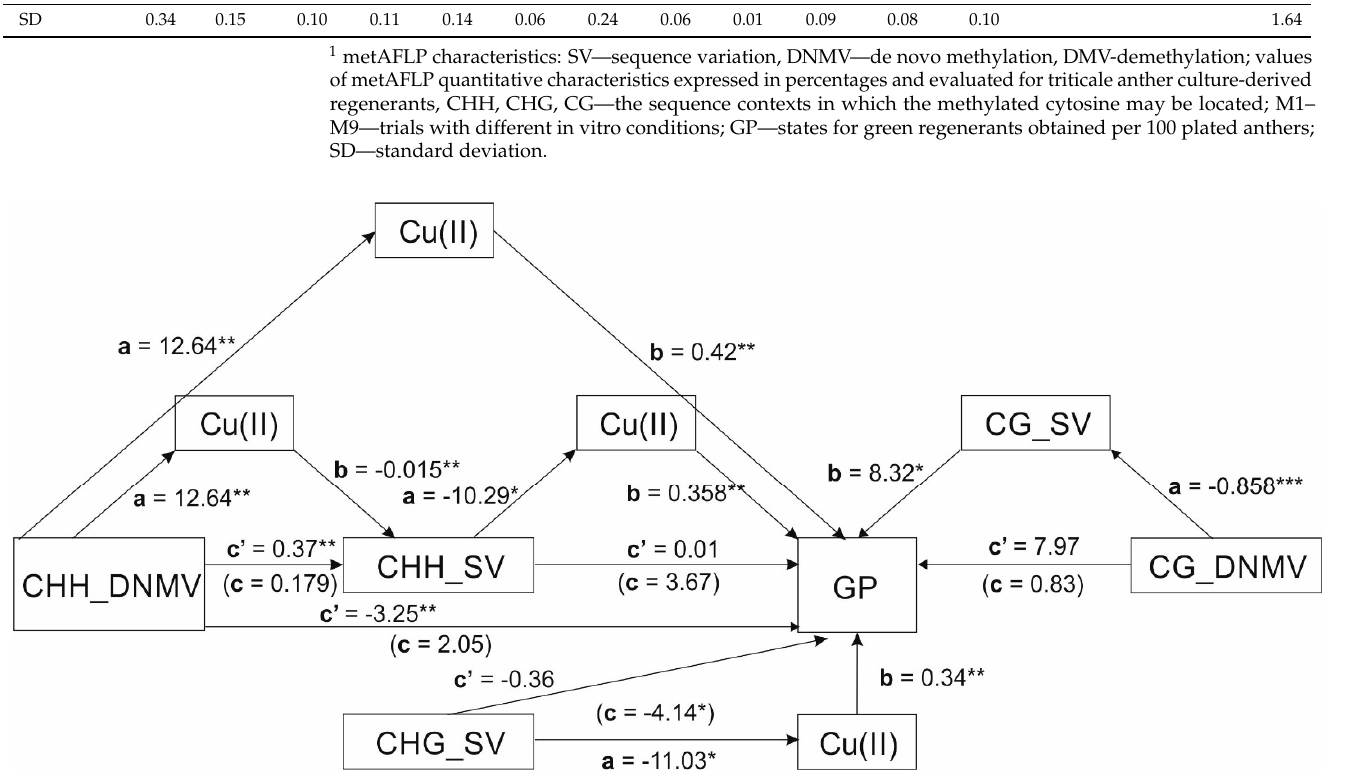
Figure 2. Schematic representation of all mediation analysis in a combined form. The unstandardized coefficients of paths a, b, c’, and c (in brackets) are indicated on respective arrows. CHH_DNMV, CHH_DNMV, CHG_DNMV, CG_DNMV, and CG_SV are the metAFLP quantitative characteristics in CHH, CHG and CG sequences; Cu(II) states for copper ions whereas GP for green plants derived via anther culture of triticale. *, **, ***—significance at p = 0.05, 0.001, or 0.0001, respectively.